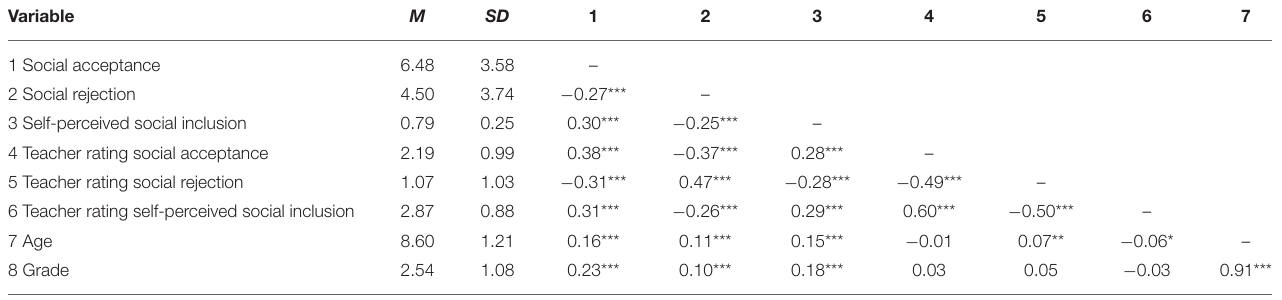
TABLE 4 | Descriptives and correlation matrix. Variable